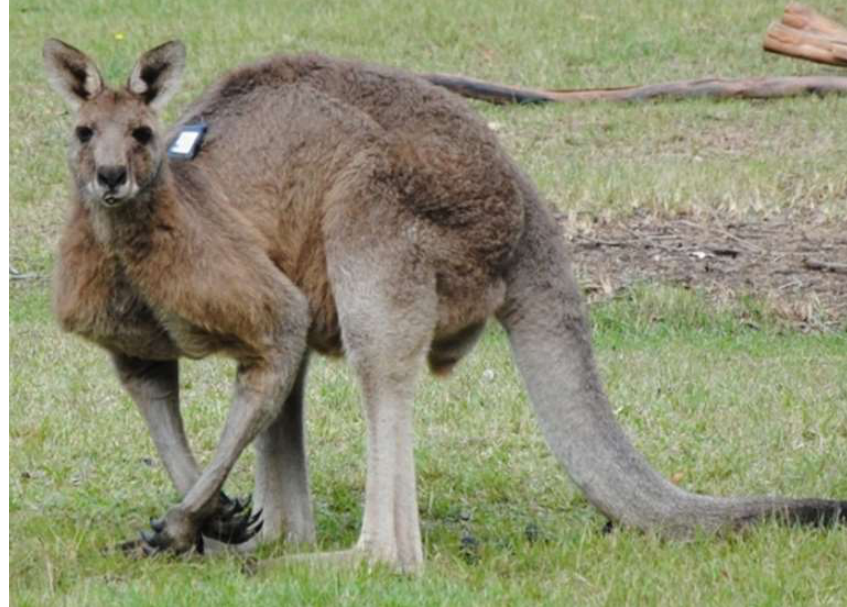
Figure 2. The position of the glue-on i-gotU GPS device on an individual. As seen, positioning the device just below the shoulders removes the stress placed on the adhesive when the kangaroo bends its neck and shoulder.